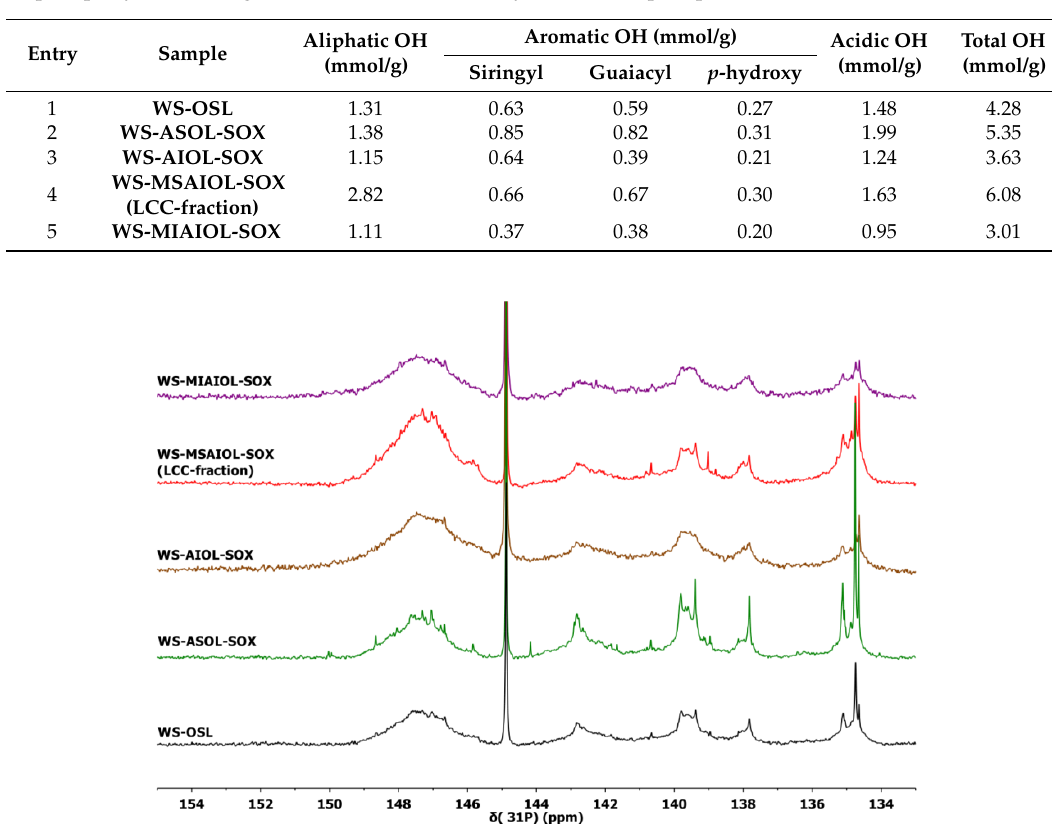
Figure 5. Quantitative 31 P NMR spectra obtained for WS-OSL and fractions derived thereof, after phosphitylation using 2-chloro-4,4,5,5-tetramethyl-1,3,2-dioxophospholan. Table 2. OH-group contents obtained for WS OSL and solubility-based fractions thereof after